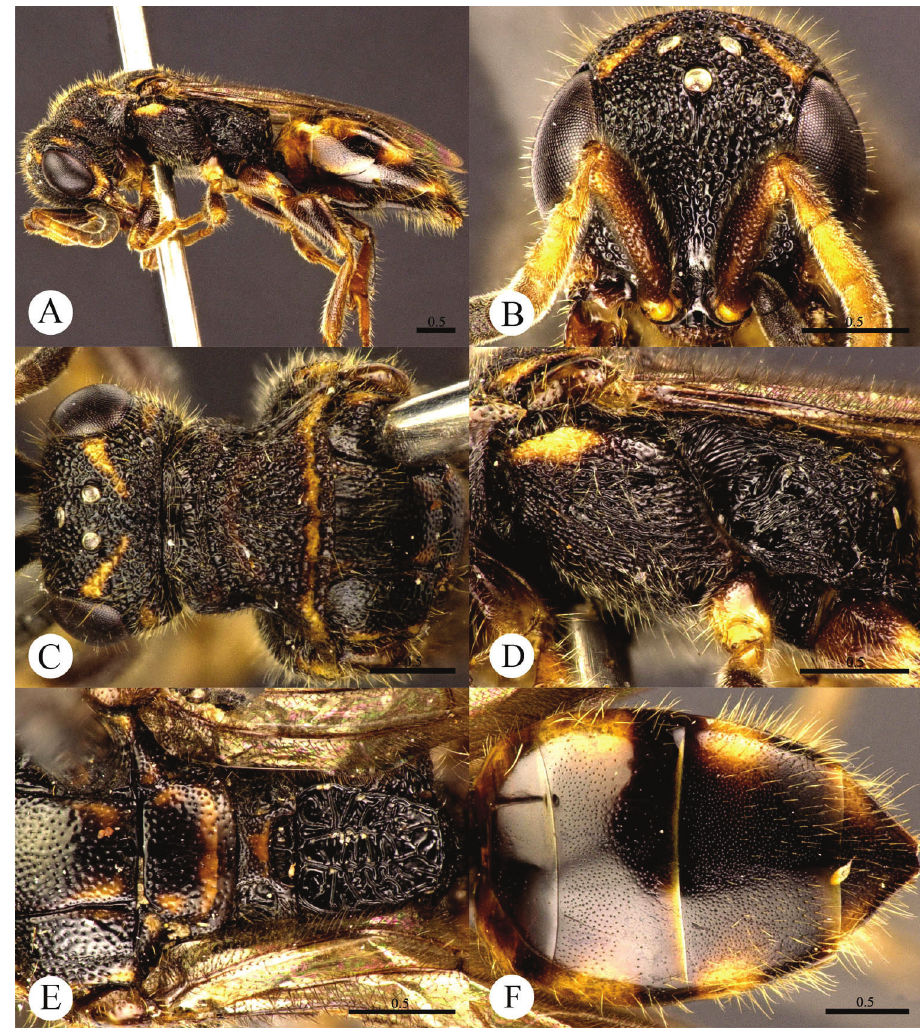
Plate 3. Cleptes flavolineatus sp. n., holotype, female. A Habitus lateral B Head anterior C Head, pronotum and mesoscutum dorsal D Mesopleuron and metapleuron lateral e Mesoscutum, mesoscutellum, metano- tum and propodeum dorsal F Metasoma dorsal. Scale bars in